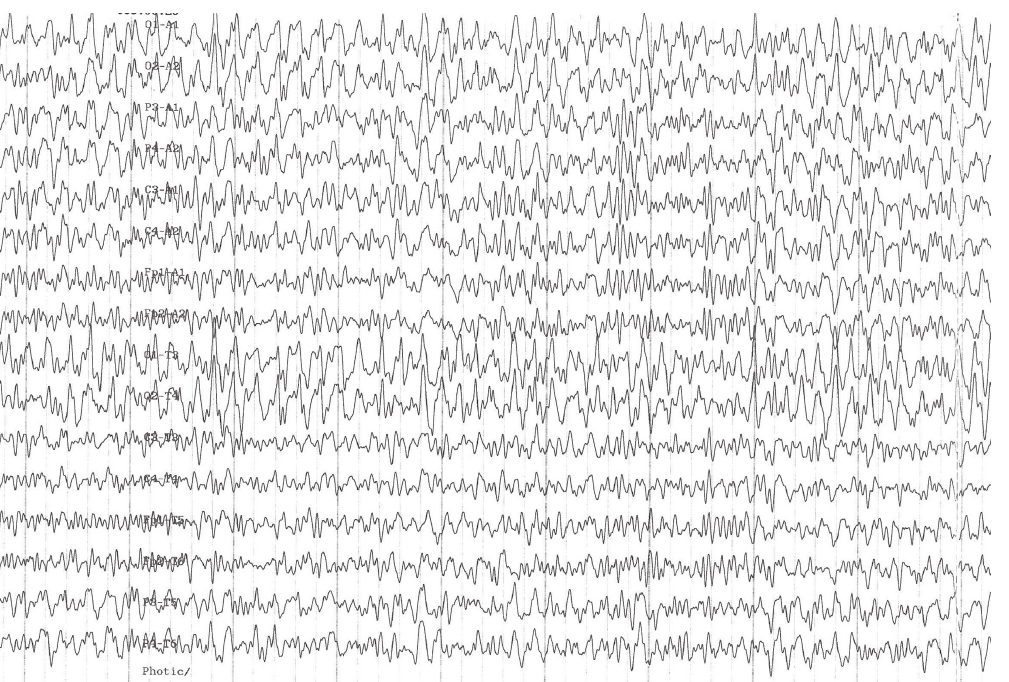
Figure 2: EEG under flickering light at age 24y showing generalised, bilaterally synchronous spike-wave and polyspike-wave complexes.